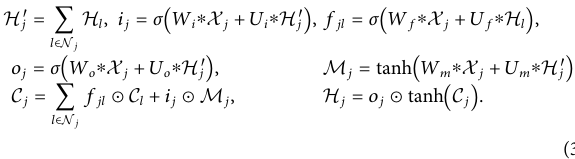
and M l ) of its children nodes. The input gate i j and output gate o j are 1 2